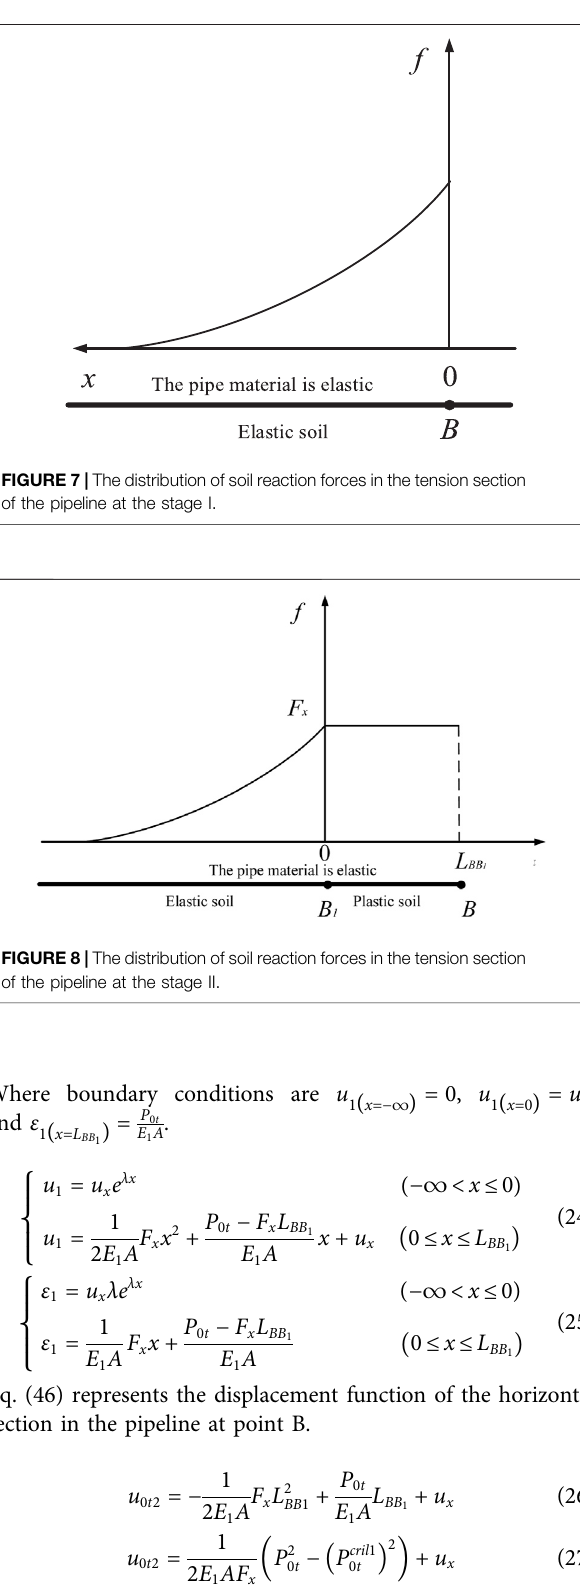
FIGURE 9 | The distribution of soil reaction forces in the tension section of the pipeline at the stage